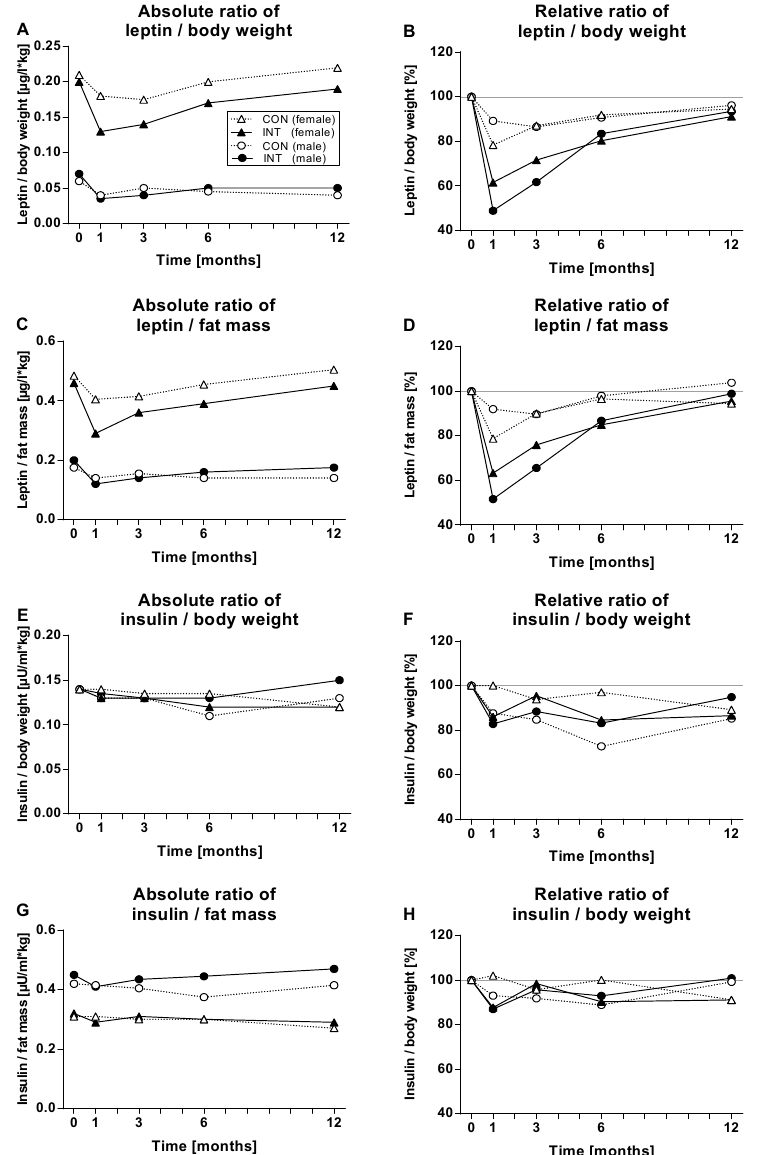
Figure 3. Shown are the median of ( A ) absolute and ( B ) relative ratios of leptin/body weight in the control (CON) and the intervention (INT) group during the 6-month intervention and 6-month follow up phase separated for female ( Δ CON, n = 80; ▲ INT, n = 195) and male ( ○ CON, n = 54; ● INT, n = 98) participants. ( C ) shows the absolute and ( D ) relative ratios of leptin/fat mass, ( E ) absolute and ( F ) relative ratios of insulin/body weight, ( G ) absolute and ( H ) relative ratios of insulin/fat mass.